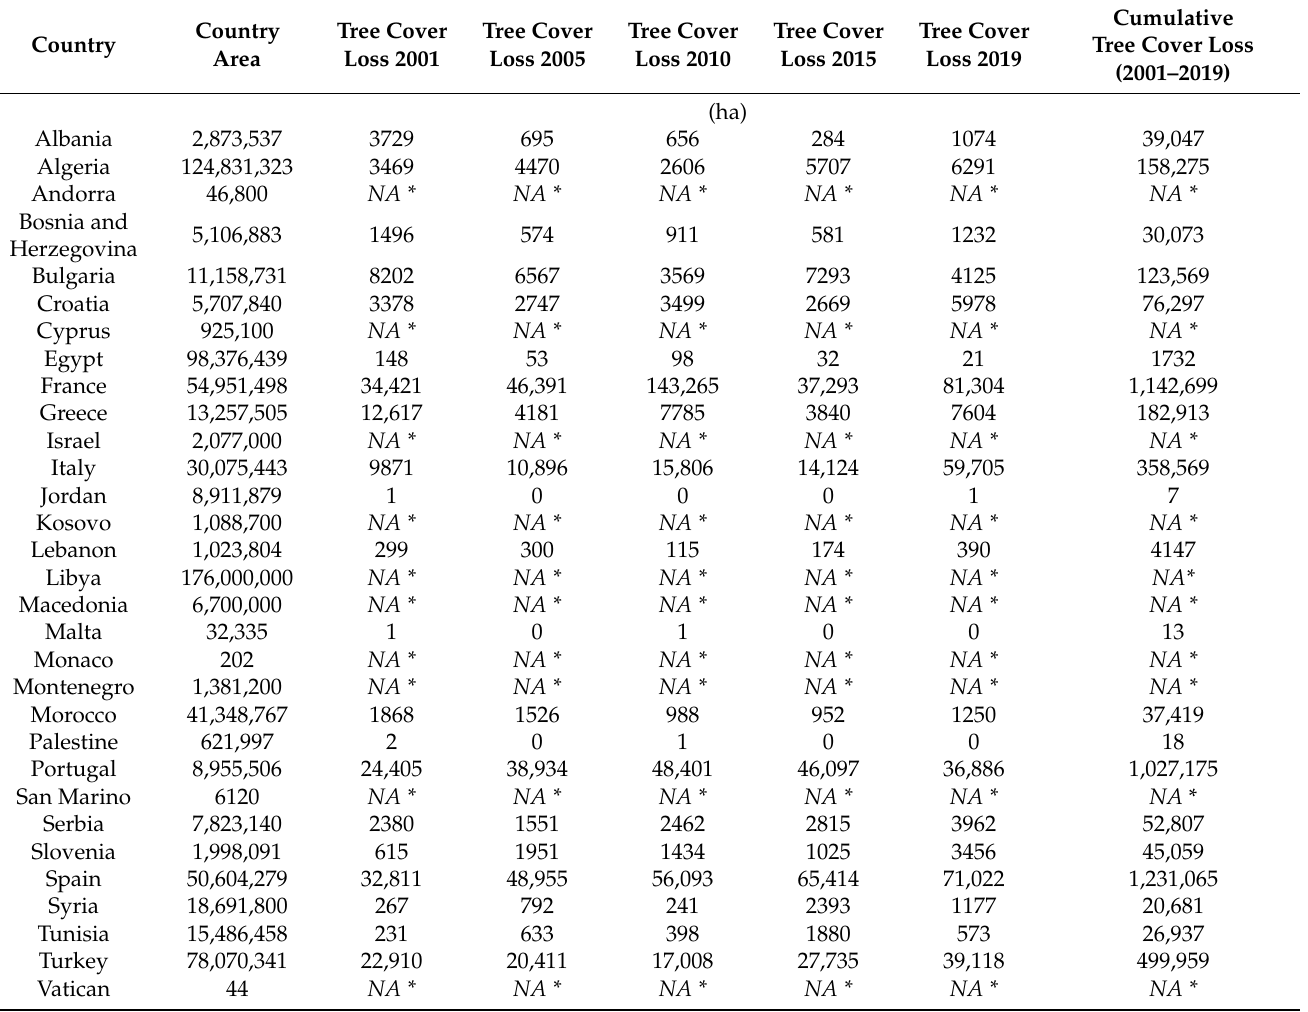
Table 2. Tree cover loss areas in countries in the Mediterranean Region [Data obtained from the Global Forest Change platform and online documentation